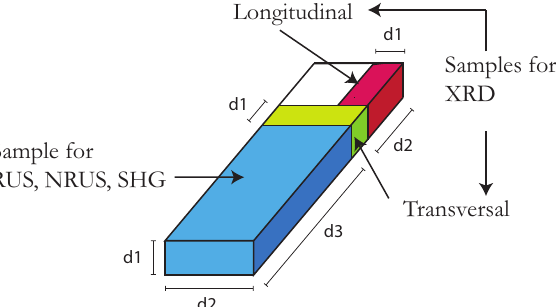
Figure 1. Schematic illustration of samples. For each thermo-mechanical treatment and for both groups, three pieces were cut for the application of acoustic methods and XRD. The longest dimension corresponds to the original’s bar axis and the cold-rolling direction. Consequently, the XRD samples are named longitudinal and